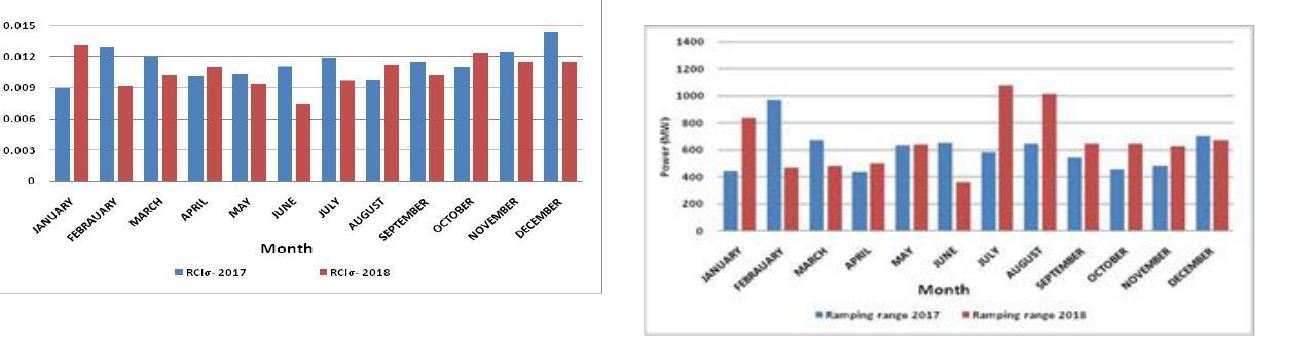
Figure 35. Comparison between the ramping range of power ramps in 15 min interval for each month for years 2017 and